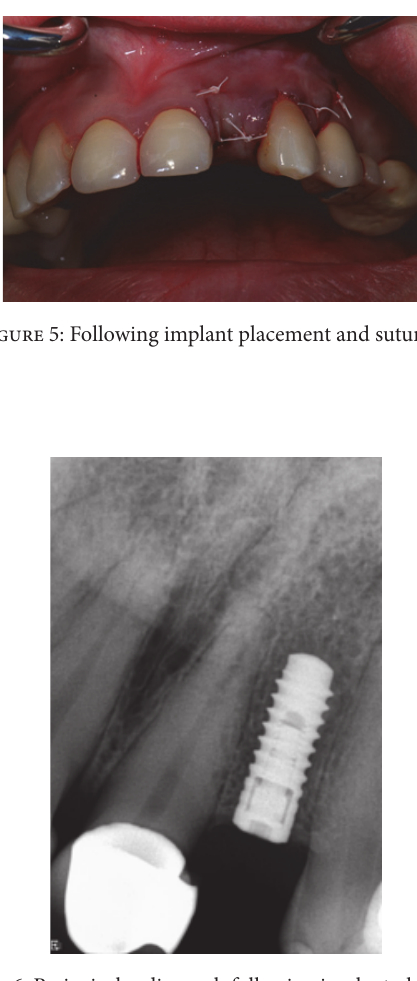
Figure 6: Periapical radiograph following implant placement.